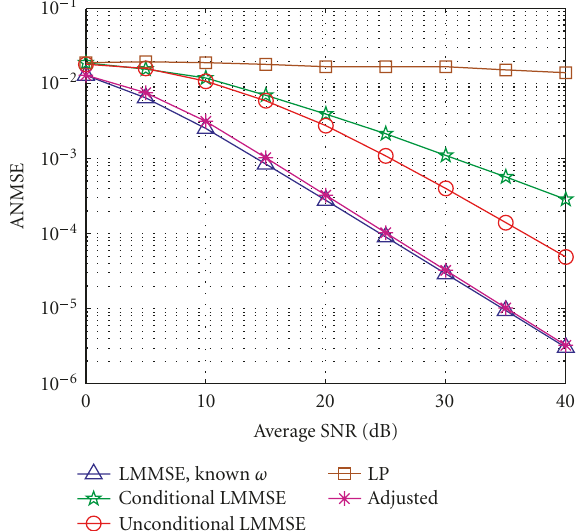
Figure 7: Adjusted NMSE of channel prediction ( L = 0 . 5 λ , N = 100, 8 rays).